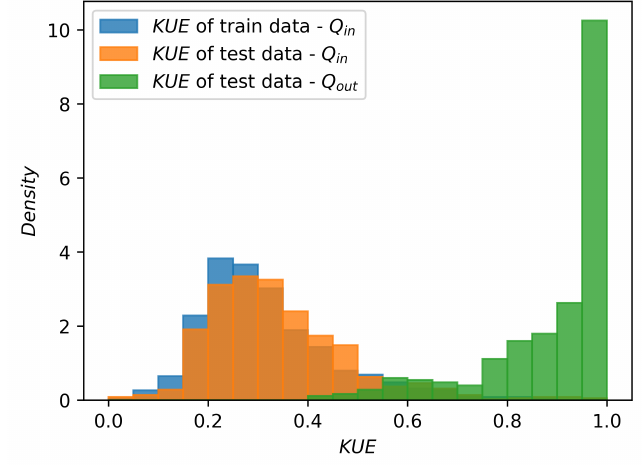
Figure 2. Histogram of the density based on the KUE values, from a train set drawn from in-distribution data, Q in , and test set drawn from both in- and out-distribution data, Q in and Q out ,